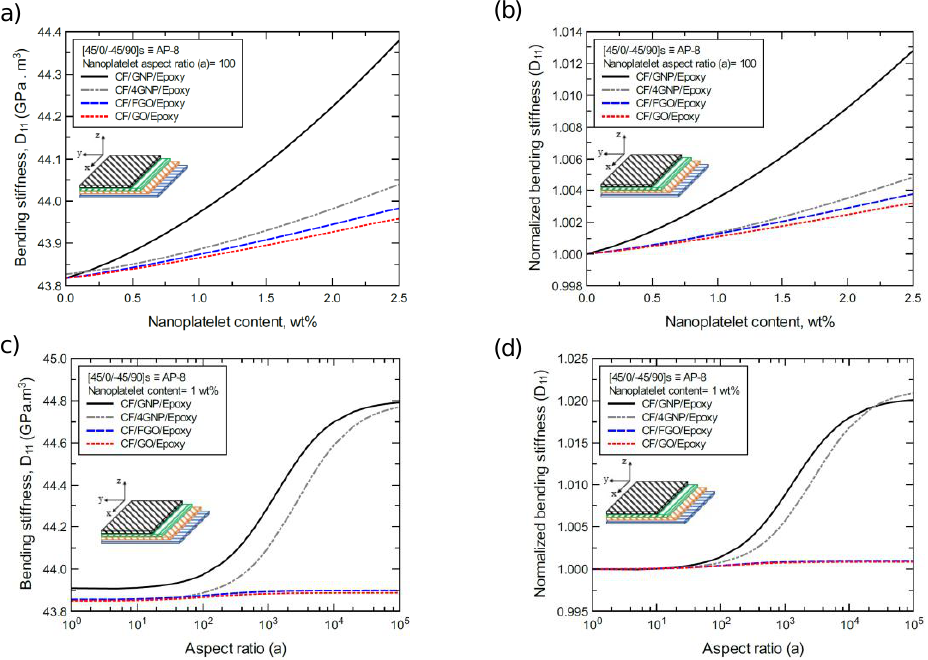
Figure 16. Comparison of the predicted bending stiffness (D 11 ) for a [45/0/-45/90]s (AP-8)-laminated composite plate based on the nanoplatelet type, content, and aspect ratio; ( a ) predicted D 11 for various nanoplatelet contents at 100 aspect ratio, and the normalized response is shown in ( b ); ( c ) predicted D 11 for various aspect ratio values at 1.0 wt% nanoplatelet content, and the normalized response is shown in ( d ). The volume fraction of CF is 56%.